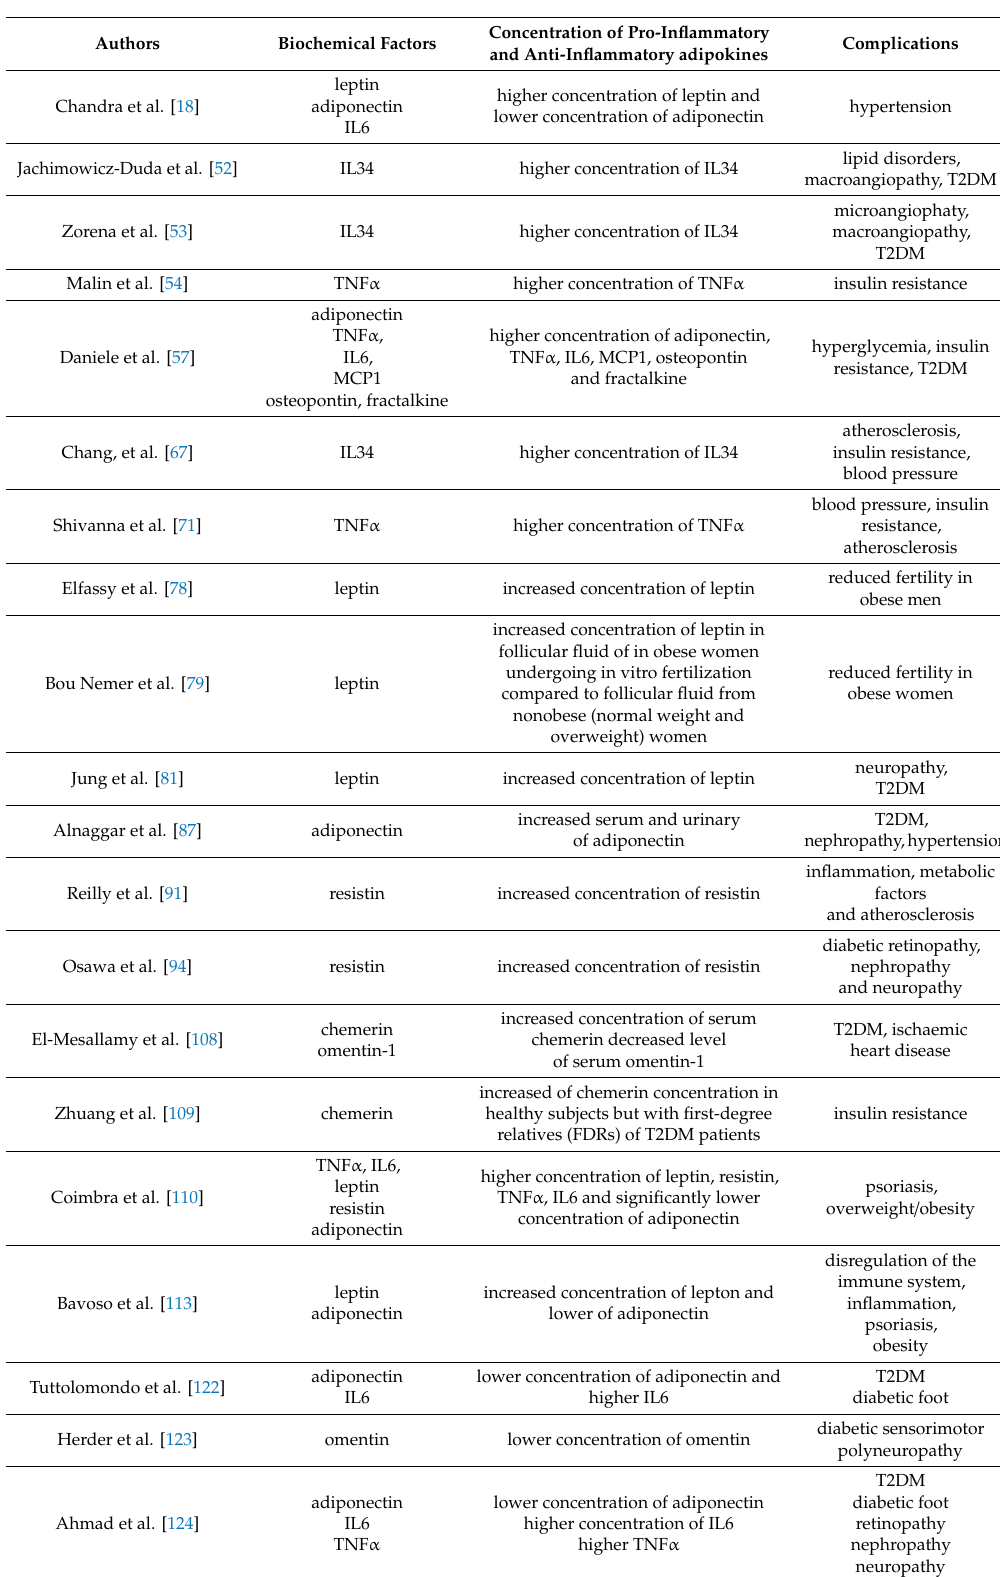
Table 1. Participation of selected pro- and anti-inflammatory adipokines in metabolic disorders and chronic complications in the course of